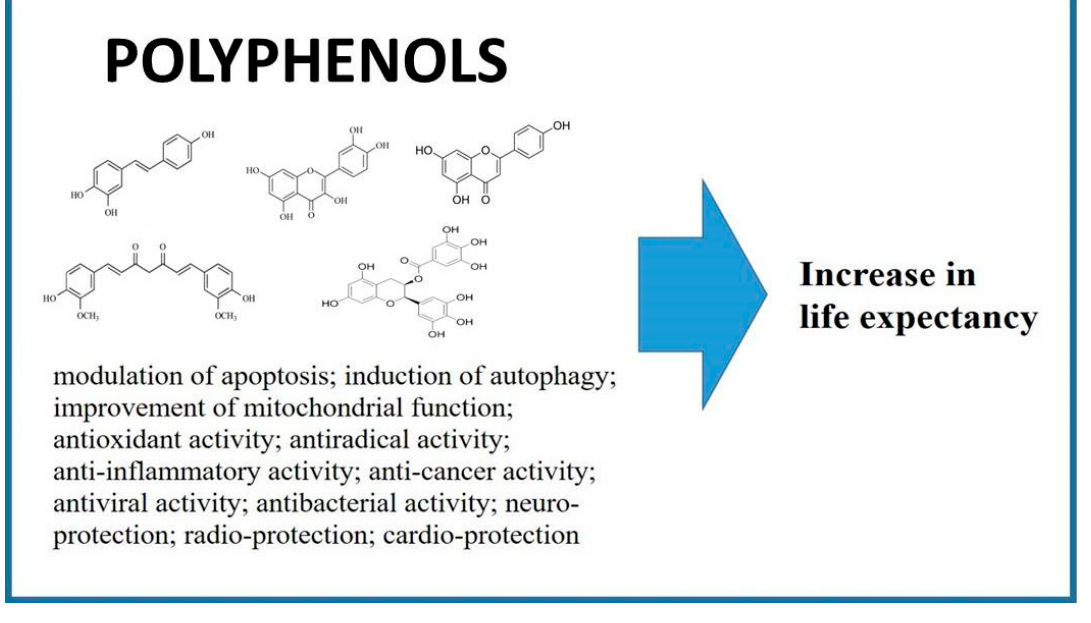
Figure 1. Biological activities of polyphenols. Modulation of apoptosis [23,24]; induction of autophagy Figure1. Biologicalactivitiesofpolyphenols.